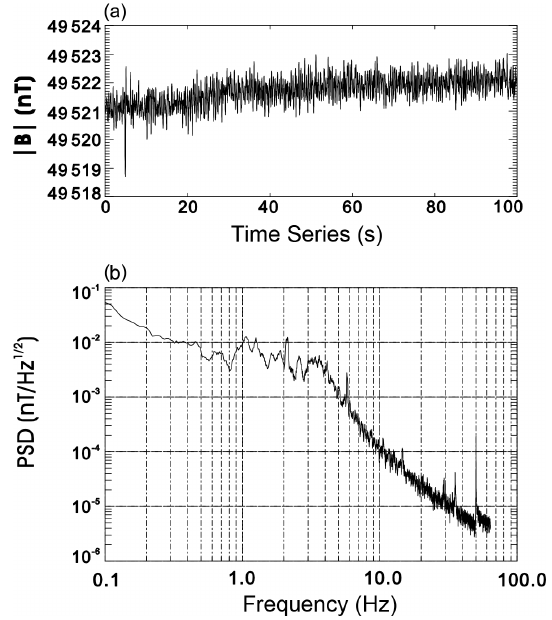
Figure 9. The noise test in a natural environment. (a) The time se- ries of the magnetic field intensity. (b) The corresponding FFT spec- trum of the time